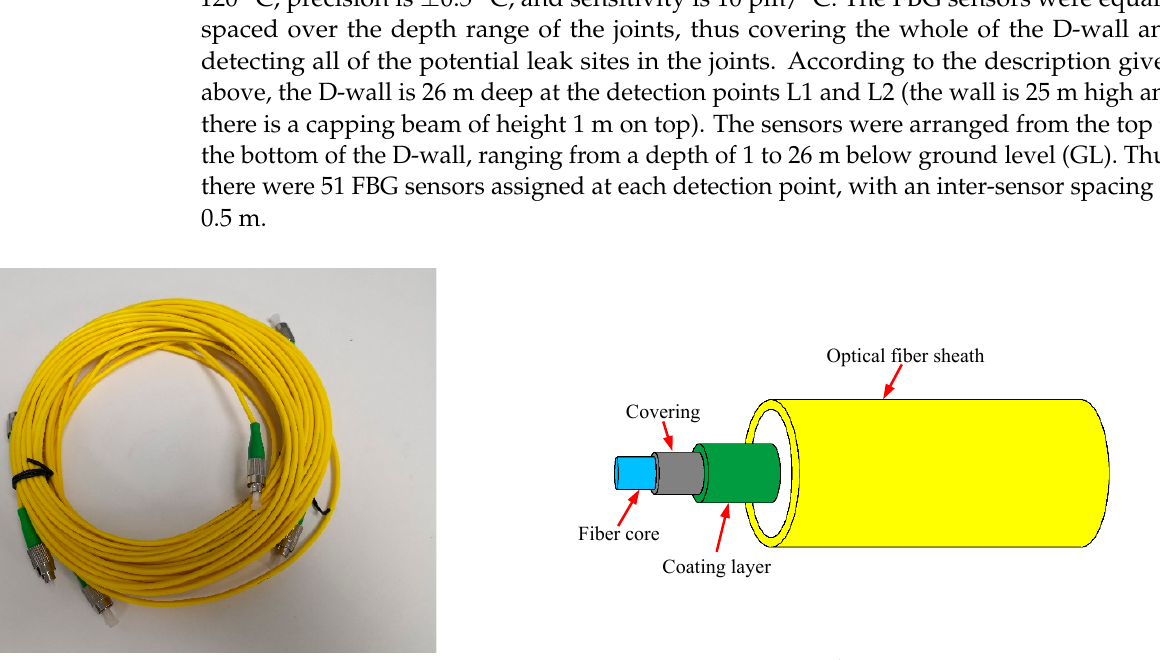
Figure 6. Top views of the test configurations considered in this work: ( a ) detection system incorporating a detection tube (i.e., schemes I; ( b ) tubeless detection system (scheme II).